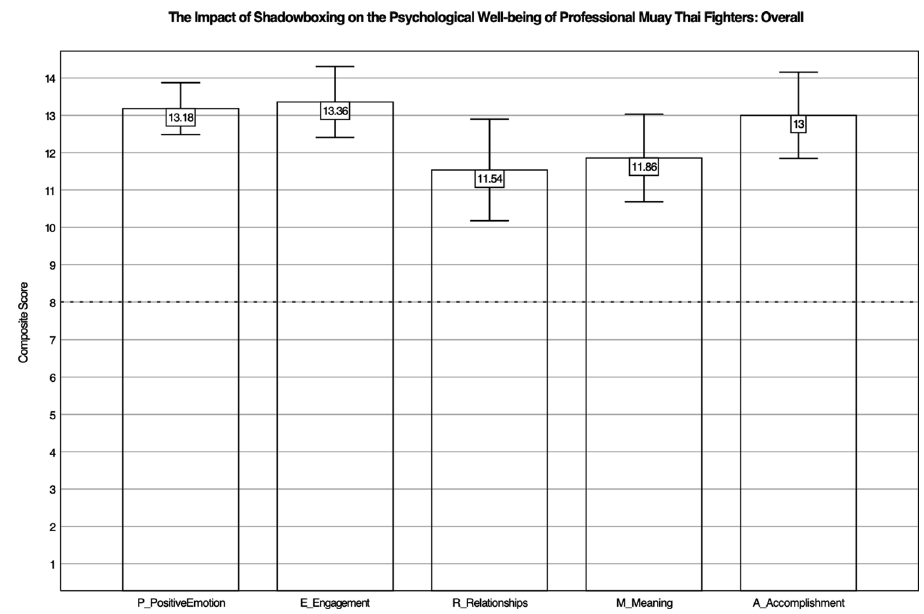
Fig. 1 This figure provides a bar plot with 95% confidence intervals (CIs) for composite PERMA scores: overall (n = 14). For each element of psychological well-being, the lowest possible composite score is 2 representing that professional Nak Muays strongly agree that shad- owboxing negatively impacts that element of psychological well-being, whereas the highest possible composite score is 14 representing that professional Nak Muays strongly agree that shadowboxing positively impacts that element of psychological well-being. A composite score of 8 (dotted line) reflects a neutral position on whether shadowboxing contributes positively or negatively to that element. Results in this figure show that professional Nak Muays strongly agree that shadowboxing positively contributes to all elements of their psychological well-being. Further, results in this figure show that shadowboxing contributes to the elements of psychological well-being in the following rank-order for professional Muay Thai fighters overall: engagement (E), positive emotions (P), accomplishment (A), meaning (M), and rela- tionships (R). Statistics were calculated using IBM SPSS Statistics